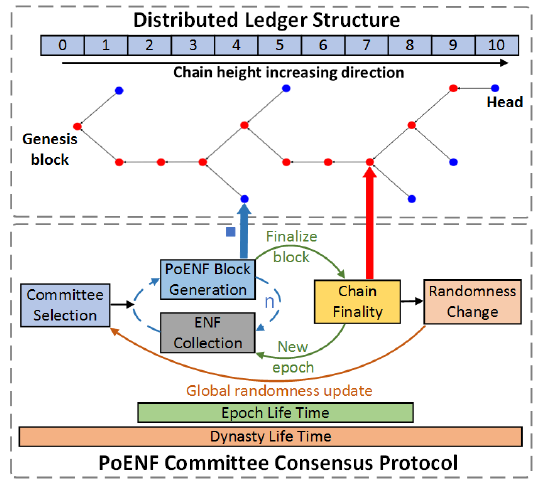
Figure 3. The PoENF consensus protocol